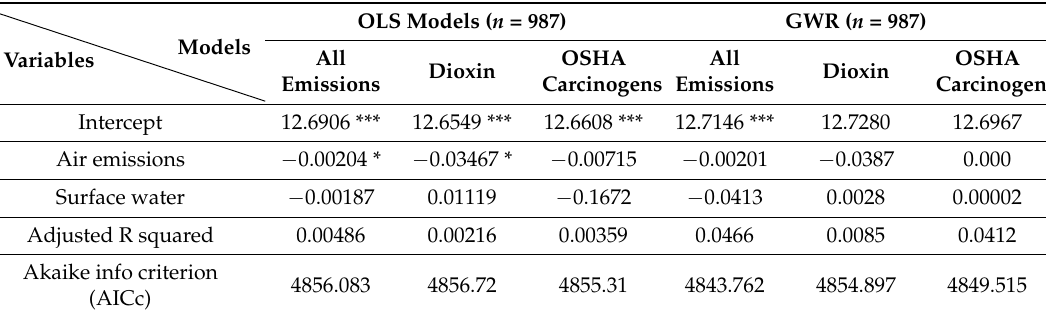
Table 2. Results of OLS regression for county-level data ( n =